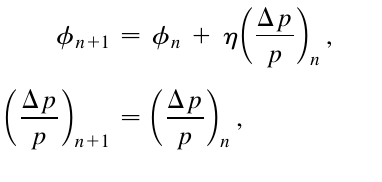
TABLE I. CELSIUS